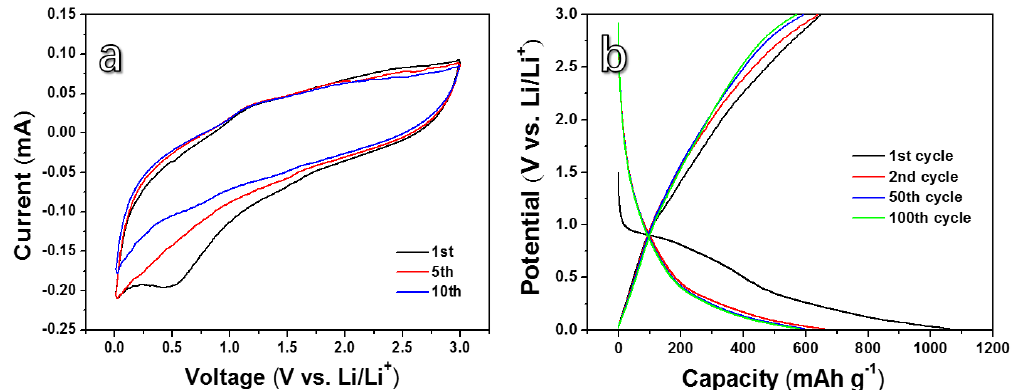
Figure 3. ( a ) Scanning electron microscopy (SEM) image of HPC and ( b – e ) transmission electron microscopy (TEM) images of HPC. Red circles marked in b and c show first class pores. Yellow circles marked in d show second class pores. Arrows in e mark the lattice fringe spacing.